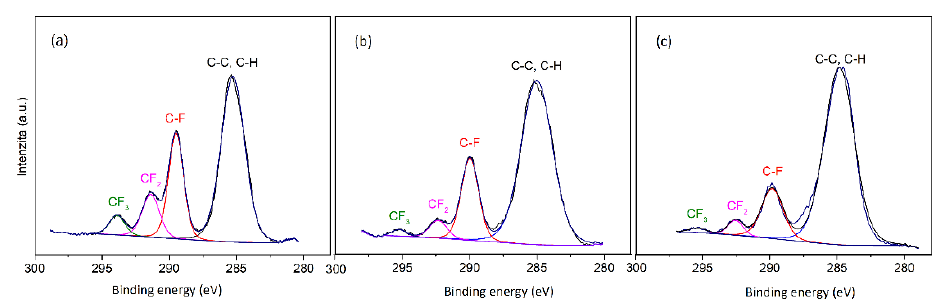
Fig. 4. The deconvolution of the C 1s peak from XPS spectra of pristine PVDF (a), modified PVDF nanofibers with H-ion implantation fluence 1.8×10 14 cm -2 (b) and (c) modified PA6 nanofibers with H- ion implantation fluence 5.6×10 14 cm -2 .